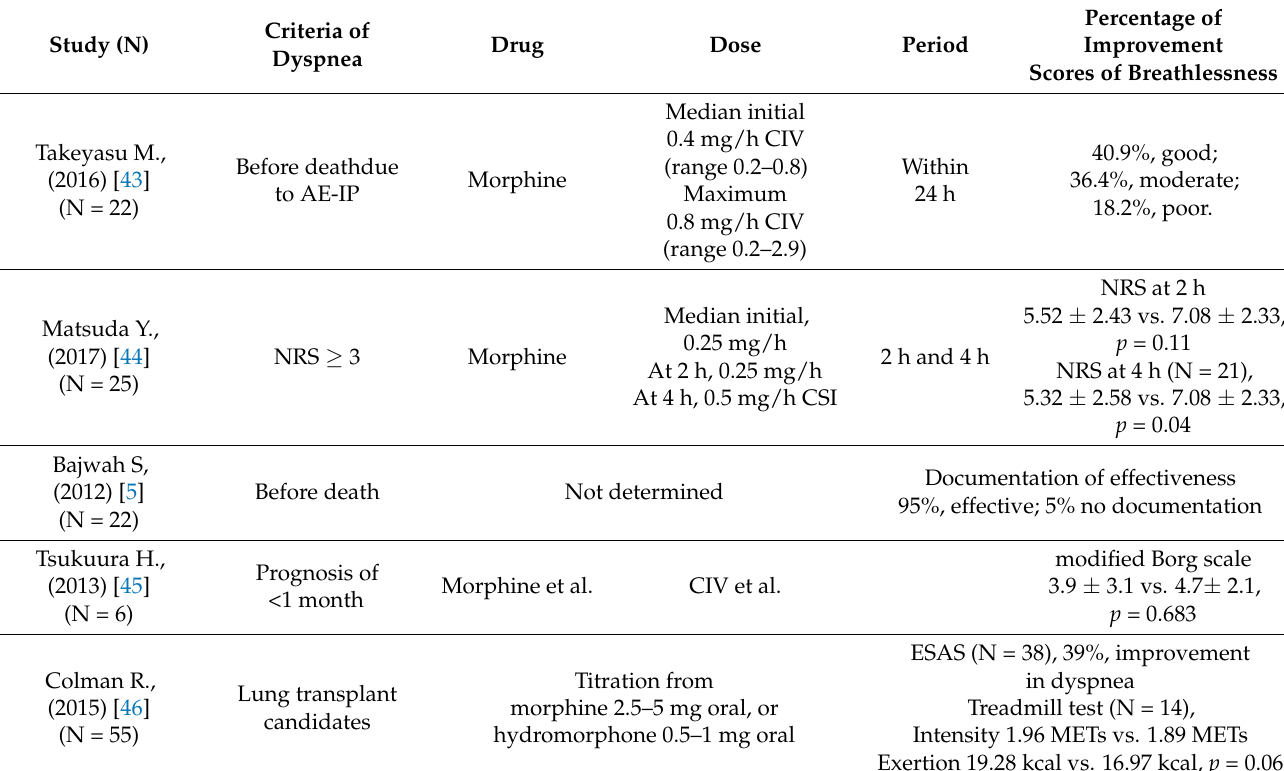
Table 6. Retrospective studies of systemic opioids for non-cancer chronic respiratory